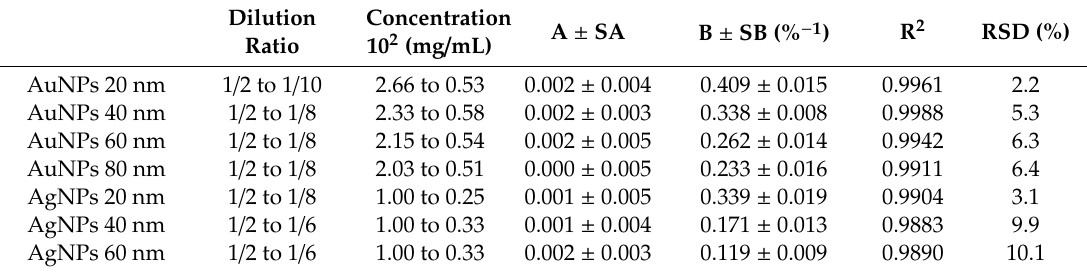
Table 1. Values of RSD (%) and correlation between peak area and dilution ratio for AuNPs (20, 40, 60 and 80 nm) and AgNPs (20, 40 and 60 nm). A: ordinate and B: slope of the straight lines. Dilution